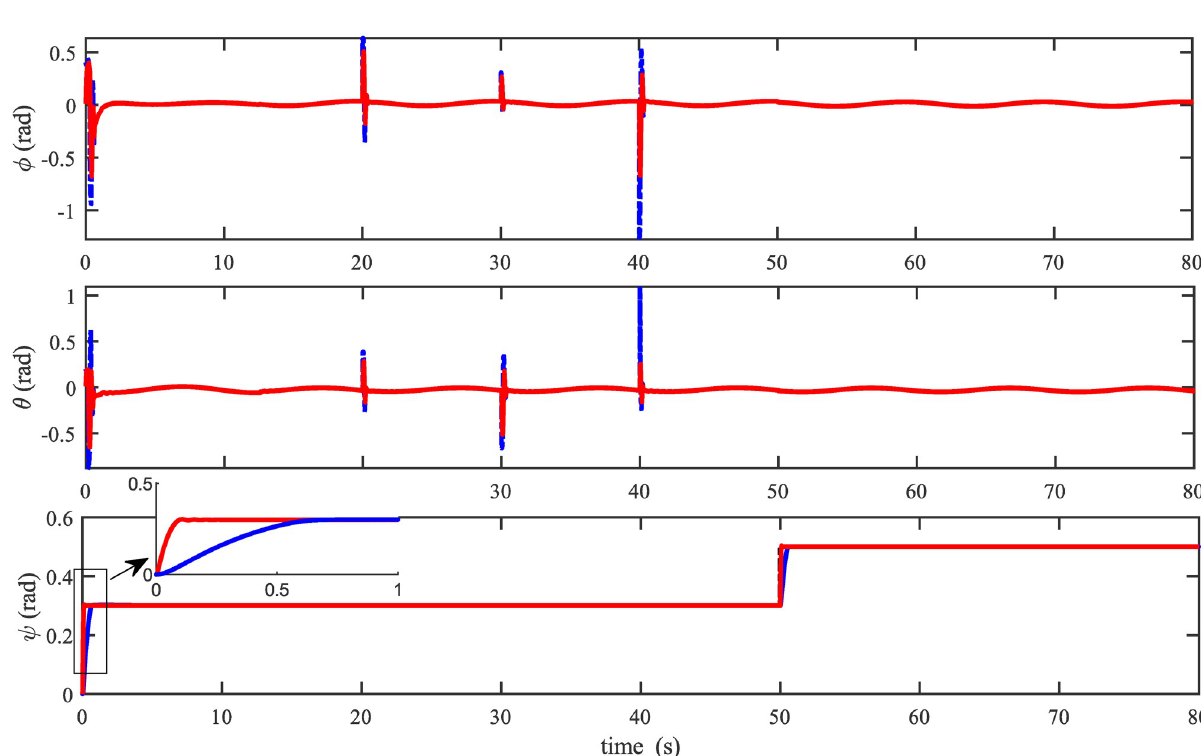
Fig 6. Results of the attitude under the proposed and ST-PID-SM controllers.